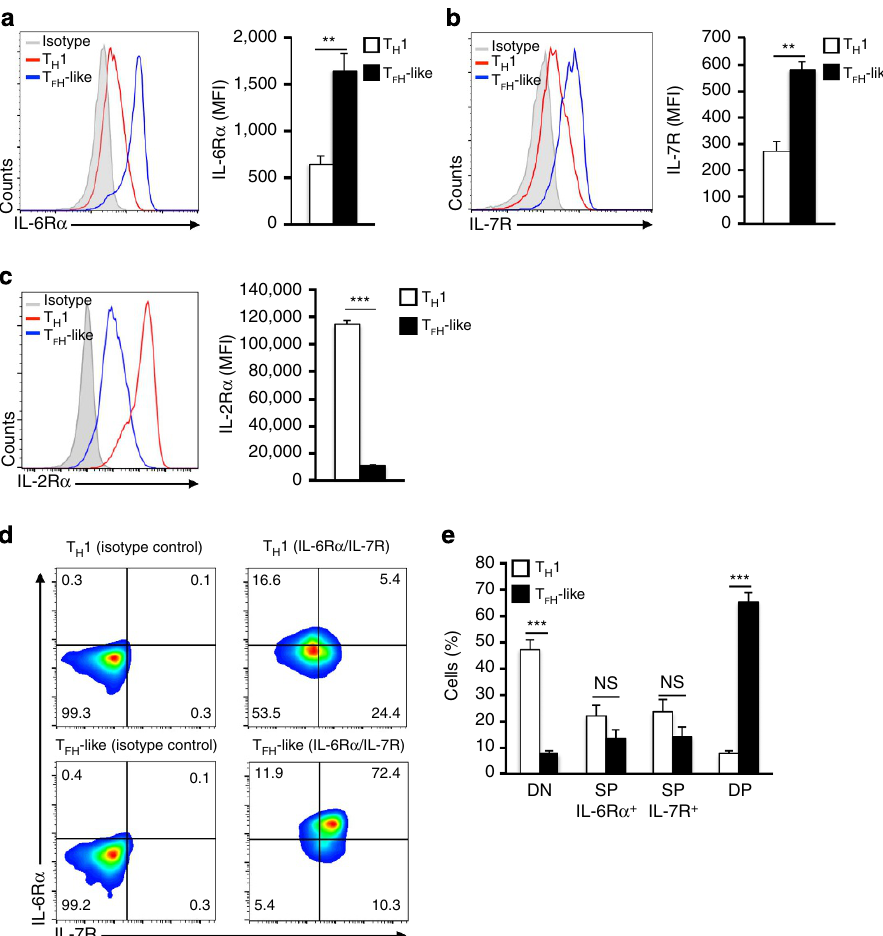
Figure 3 | T H 1 cells undergo cytokine receptor reprogramming to dually express IL-6R a and IL-7R. Primary CD4 þ Tcells were cultured in T H 1 conditions and exposed to either high (T H 1 cells) or low (T FH -like cells) environmental IL-2 (250Uml (cid:2) 1 or 10Uml (cid:2) 1 , respectively). ( a – e ) Cell surface expression of IL-6R a , IL-7R or IL-2R a was measured by flow cytometric analysis. Data are represented as histograms ( a – c ), flow cytometry dot plots ( d ) or quantified percent positive cells ( e ). Average mean fluorescence intensity (MFI) for IL-6R a , IL-7R and IL-2R a expression is shown (mean of n ¼ 3 ± s.e.m.). ** P o